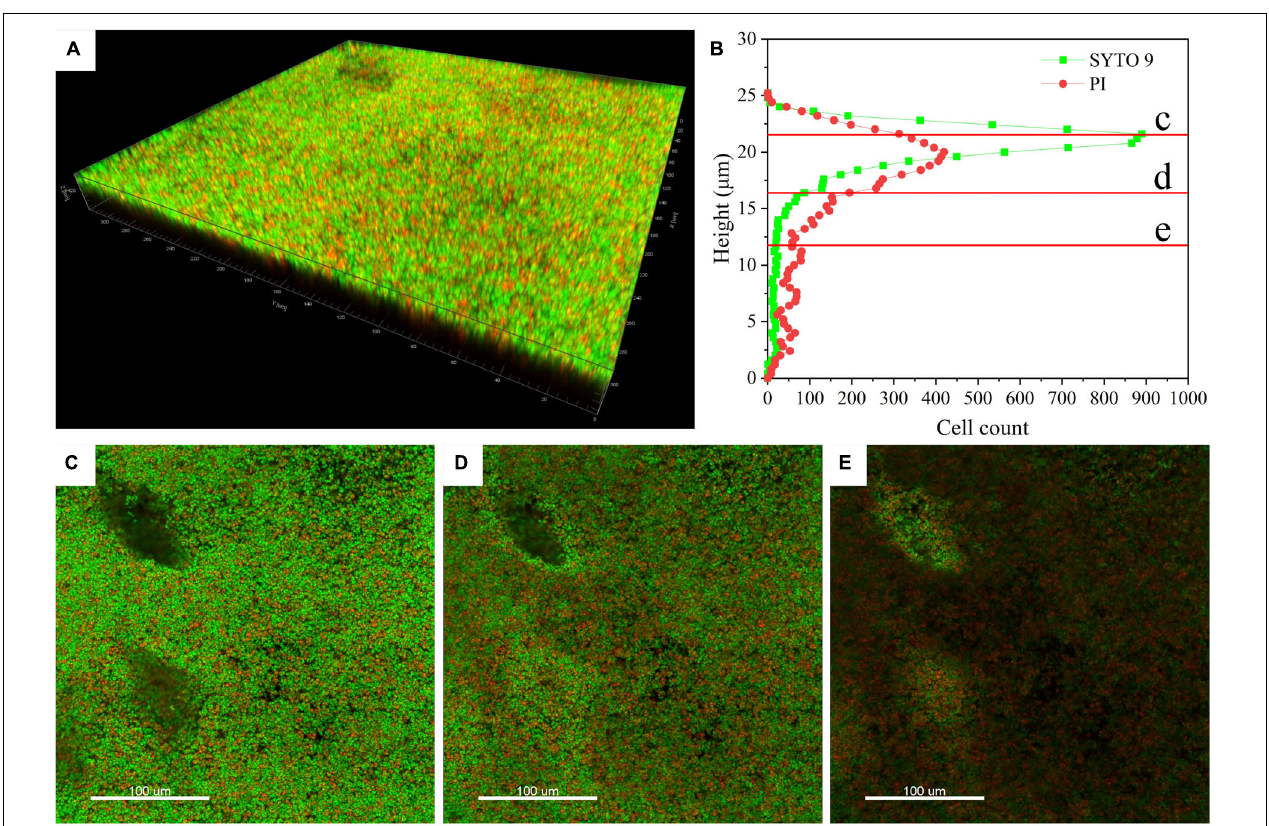
FIGURE 3 | Confocal laser scanning microscopy (CLSM) images of T. halophilus biofilms. (A) CLSM images of biofilm stained by PI (dead cells, red) and SYTO 9 (live cells, green). (B) The distribution of live cells and dead cells at different heights. (C–E) CLSM images at different focal planes which are marked c, d, and e in figure B, respectively. The three-dimensional reconstruction and cell distribution were performed by Imaris